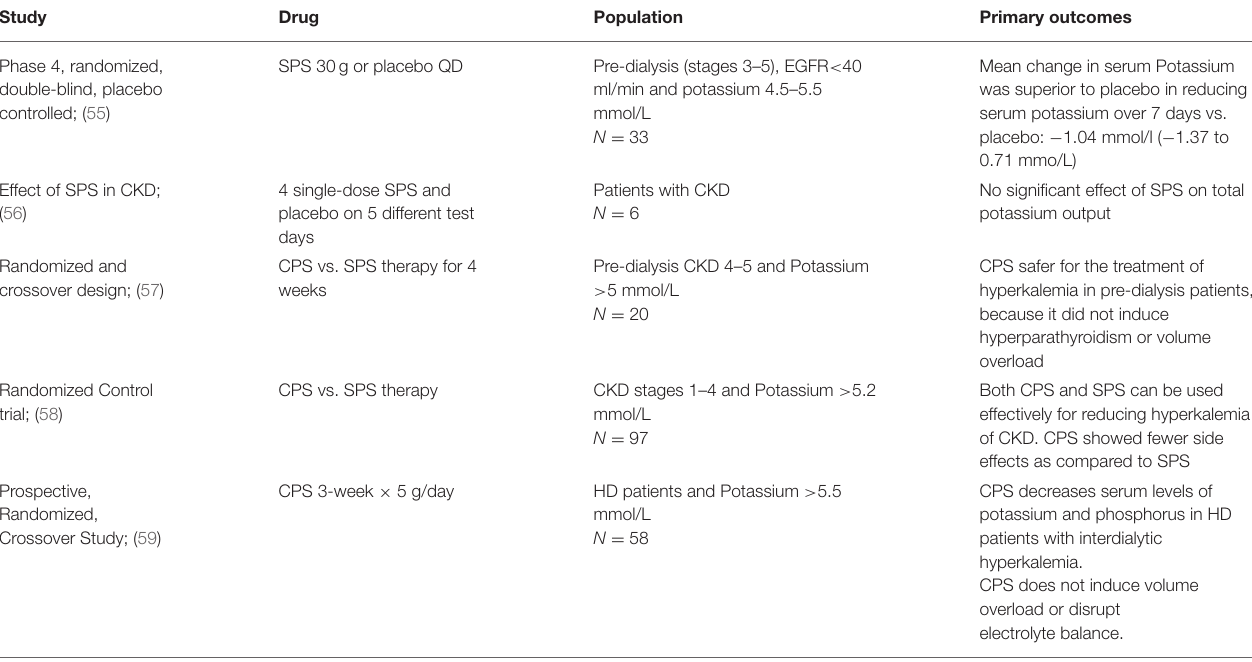
TABLE 2 | Clinical studies of sodium and calcium polysterene sulfonate (54). Study